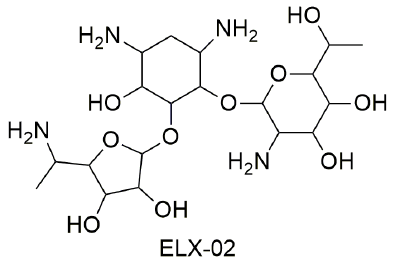
Figure 4. Structure of ELX-02.